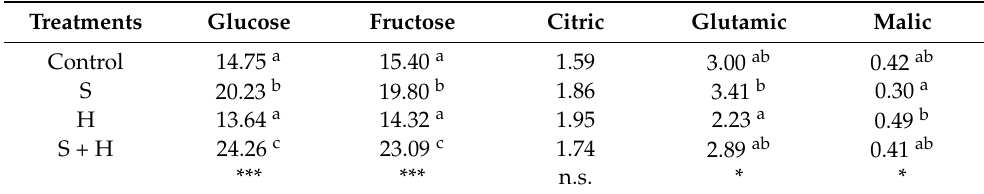
Table 2. Concentration of soluble sugars and organic acids (mg g − 1 fresh weight) in tomato fruits under control (C), saline (S) and heat conditions (H) or the combination of salinity and heat (S + H). Values are means ( n = 6).